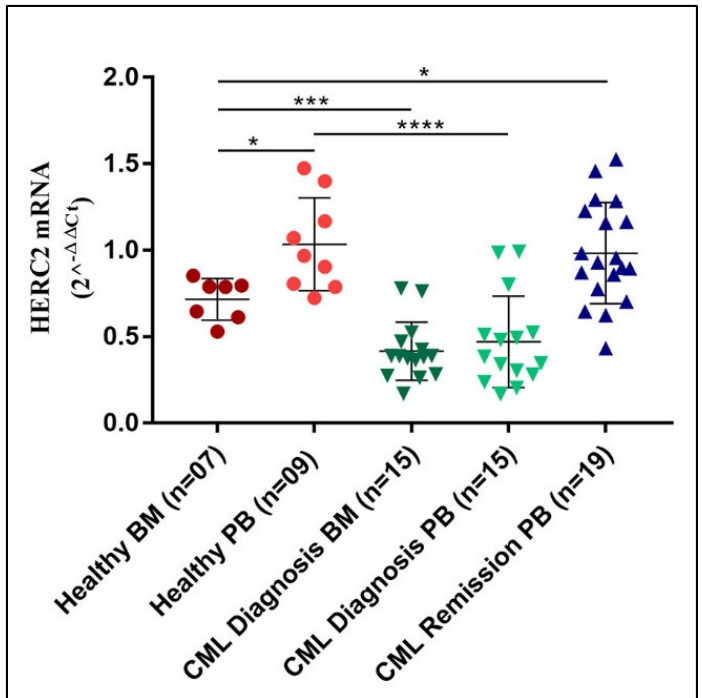
Figure 1. HERC2 gene expression is differentially regulated PB and BM from healthy subjects, and it is down-modulated in newly diagnosed CML patients. HERC2 gene was differentially expressed in BM and PB specimens from healthy subjects, displaying a significantly lower transcript amount in BM. When compared to the controls, newly diagnosed CML patients showed lower HERC2 mRNA levels, both in PB and BM samples. Remarkably, when CML patients reached remission, the HERC2 gene expression raised again to levels comparable to those encountered of healthy donors. p ≤ 0.05 = *; p ≤ 0.001 = ***; p ≤ 0.0001 =